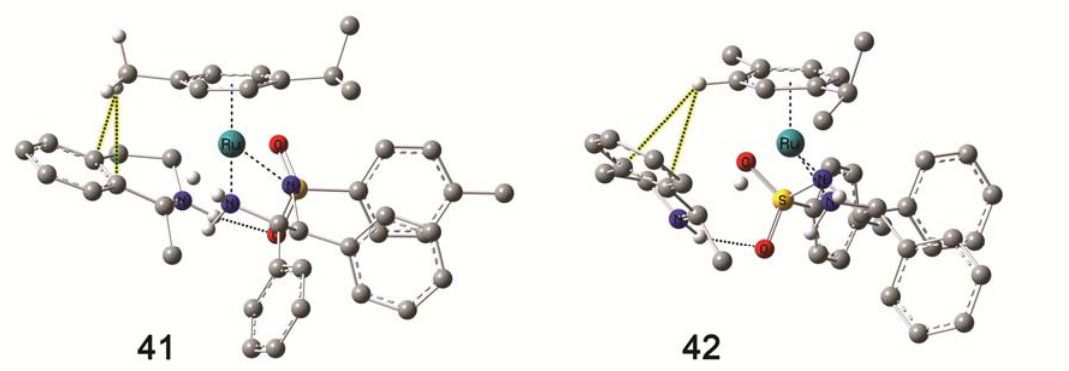
Figure 9. Optimized structures of favTSs utilizing C(sp 3 )H/ π ( 41 ) or C(sp 2 )H/ π ( 42 ) interactions (shown in green). The unnecessary hydrogen atoms have been omitted for